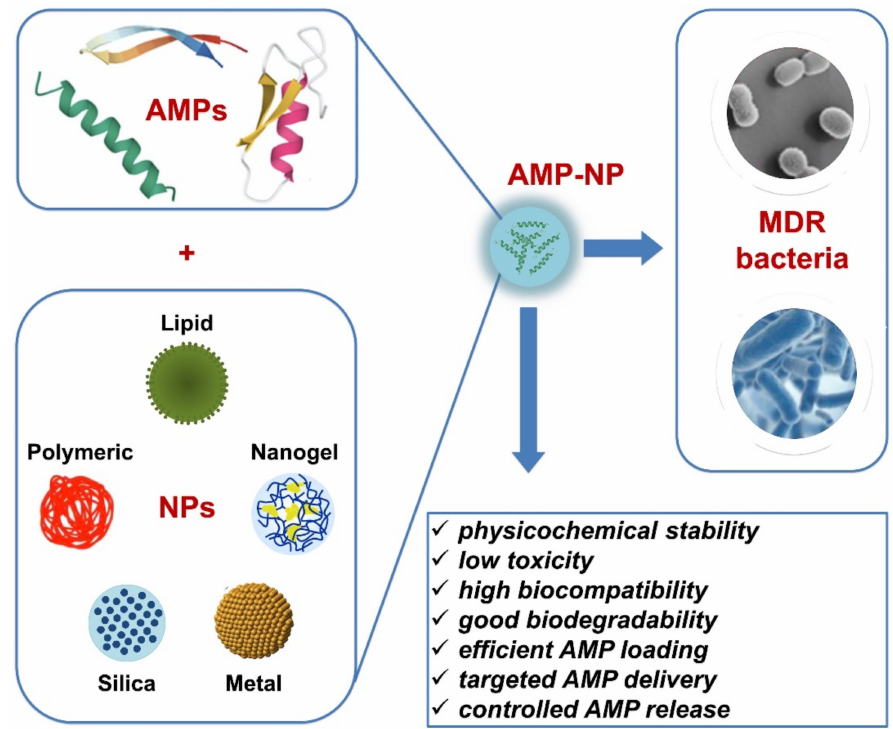
Figure 1. Overview of nanosystems for AMP delivery, such as lipid-based, polymeric, silica-based, metal, and nanogels. Once encapsulated, the AMPs (AMP-NP) displayed not only antimicrobial activities against MDR pathogens, but also improved properties in terms of stability, toxicity, biocom- patibility, and biodegradability. The selected system will need also to assure efficient AMP loading, AMP targeted delivery, and AMP controlled